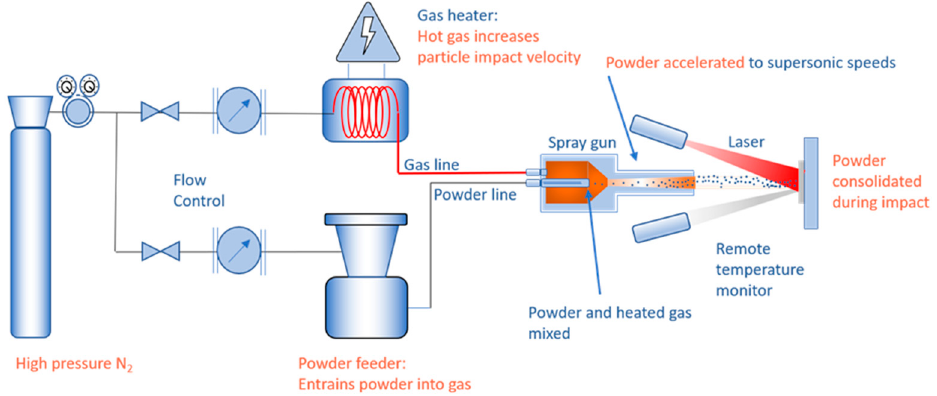
Figure 1. Schematic diagram showing SLD equipment.